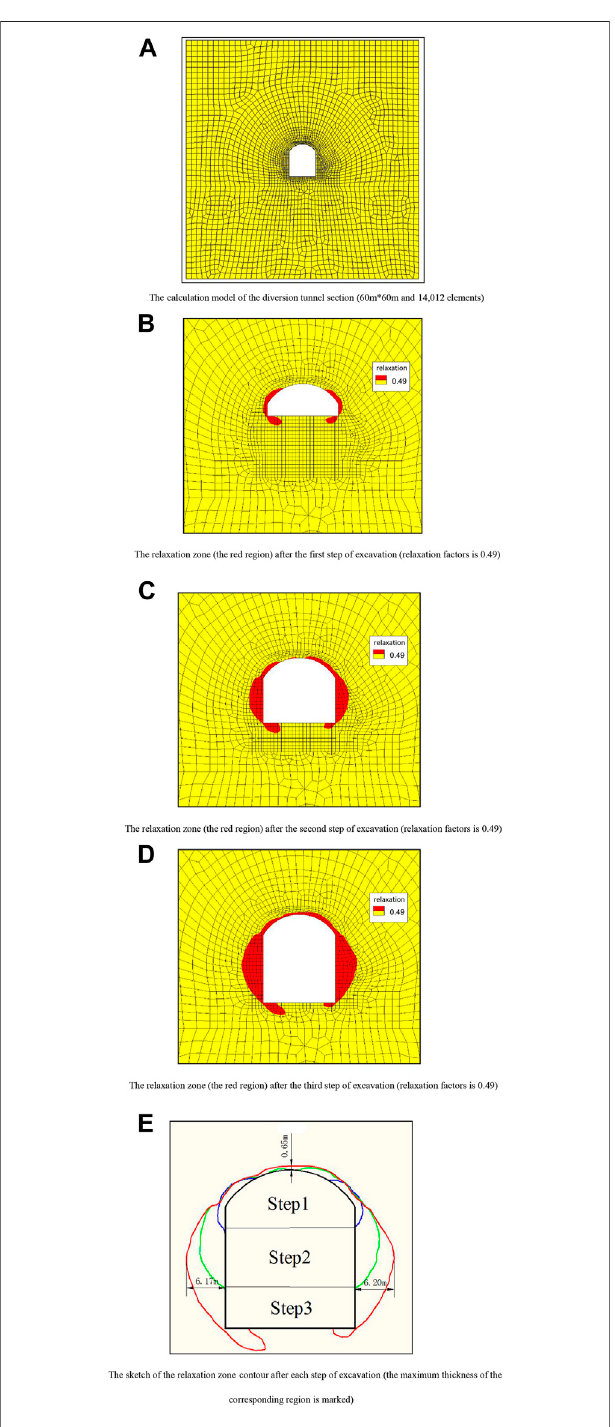
FIGURE8| Thecalculationmodelandresults. (A) Thecalculationmodel of the diversion tunnel section (60 m*60 m and 14,012 elements). (B) The relaxation zone (the red region) after the fi rst step of excavation (relaxation factors is 0.49). (C) The relaxation zone (the red region) after the second step of excavation (relaxation factors is 0.49). (D) The relaxation zone (the red region) after the third step of excavation (relaxation factors is 0.49). (E) The sketch of the relaxation zone contour after each step of excavation (the maximum thickness of the corresponding region is marked).